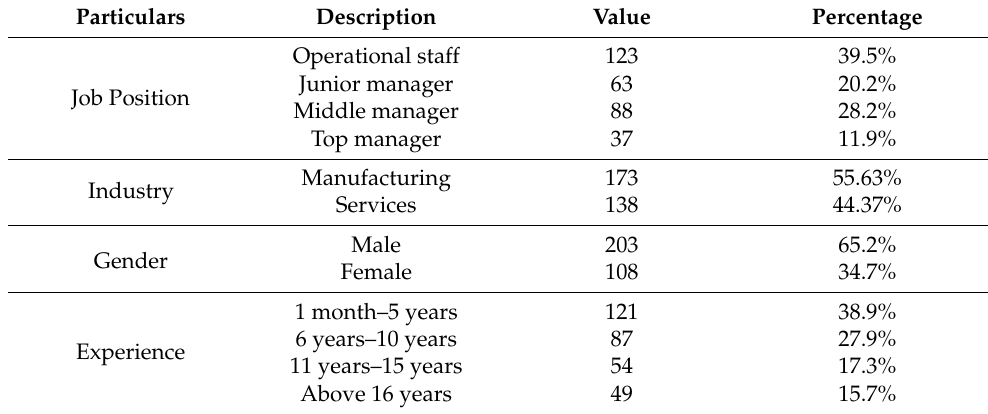
Table 1. Demographic of